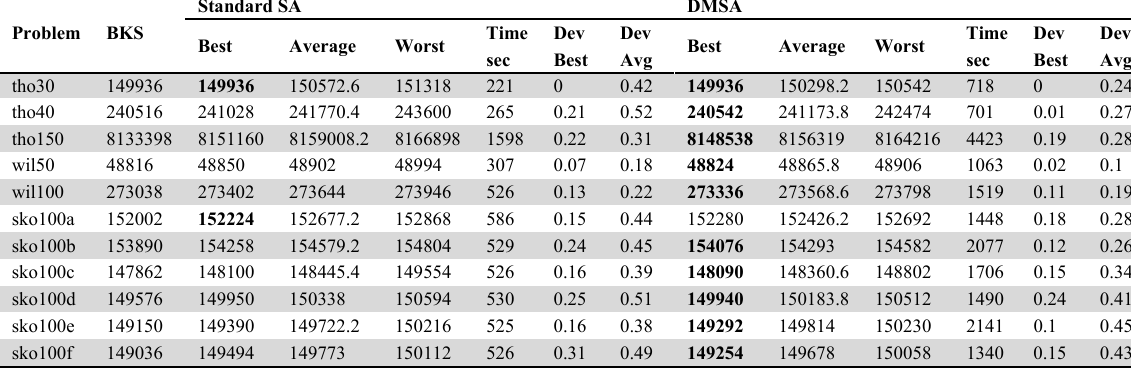
The summarized results obtained by Standard SA and DMSA algorithm over 10 runs Problem